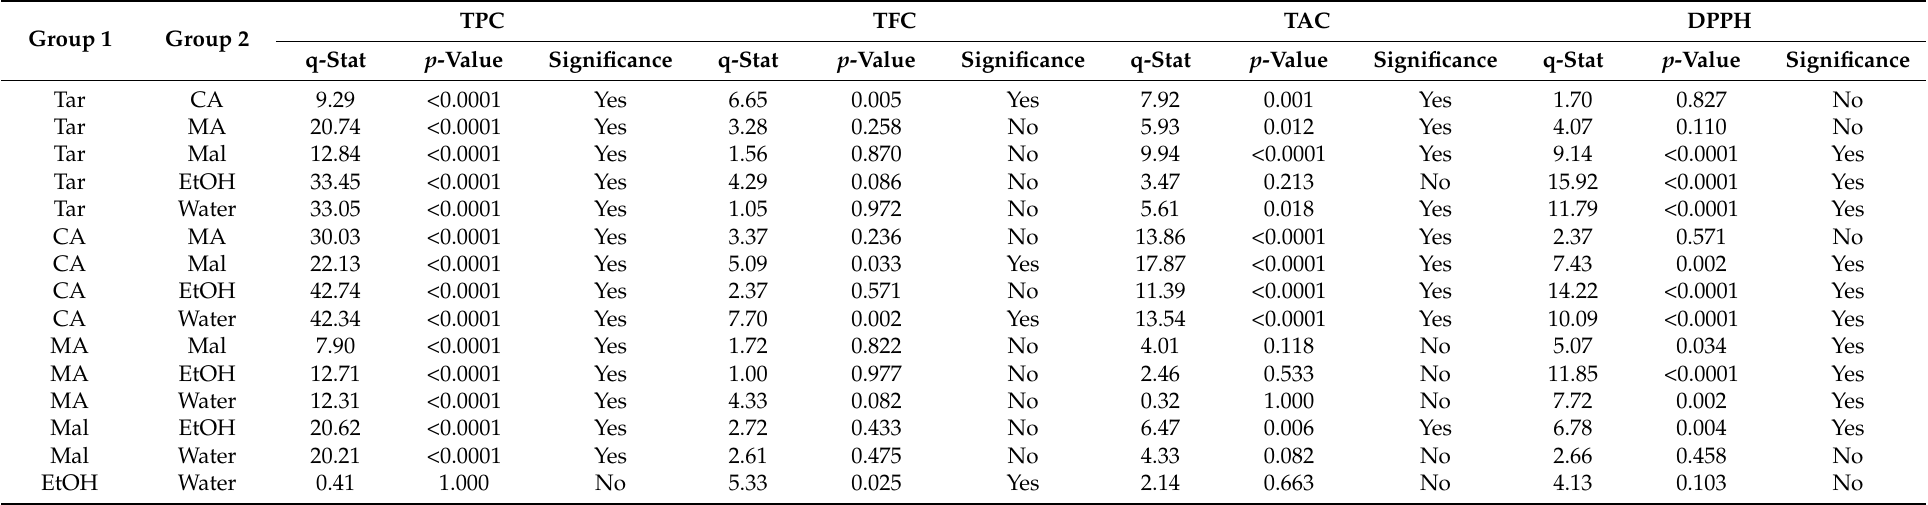
Table 3. Results of Tukey’s HSD test of estimation a statistically significant difference at p ≤ 0.05 between solvents for TPC, TFC, TAC, and DPPH.